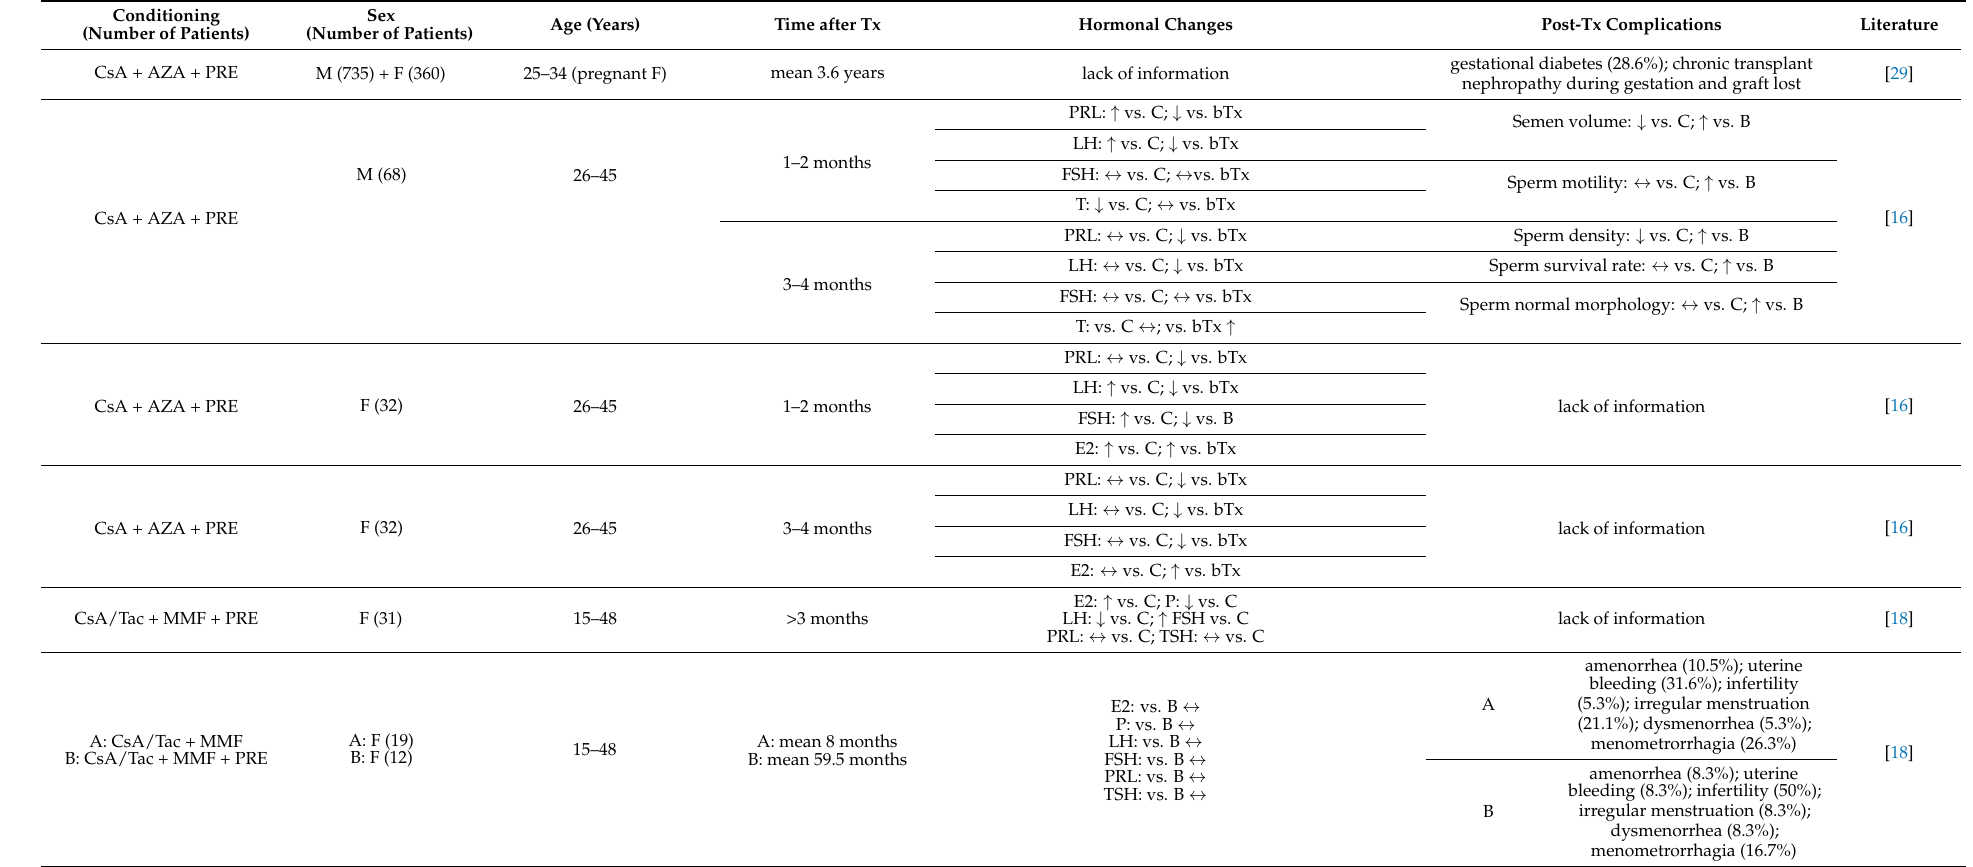
Table 1. Demographical and medical data of renal transplant